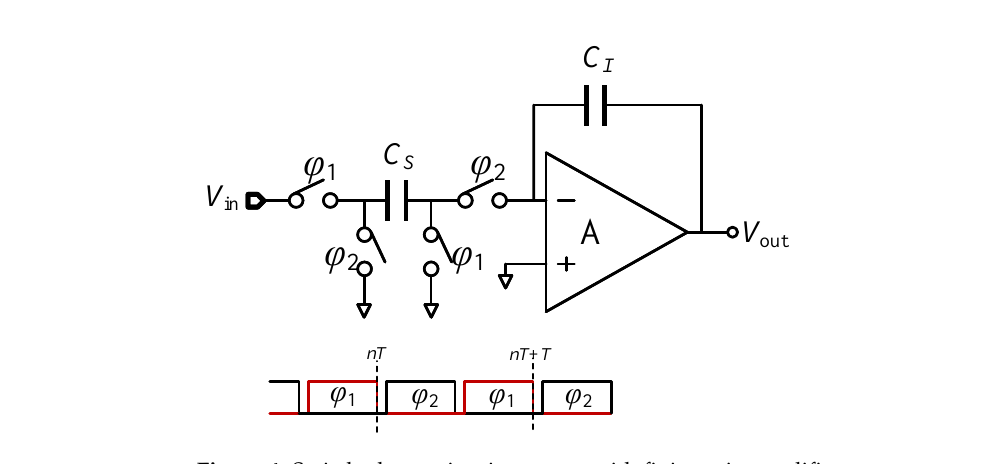
Figure 4. Switched-capacitor integrator with finite-gain amplifier.